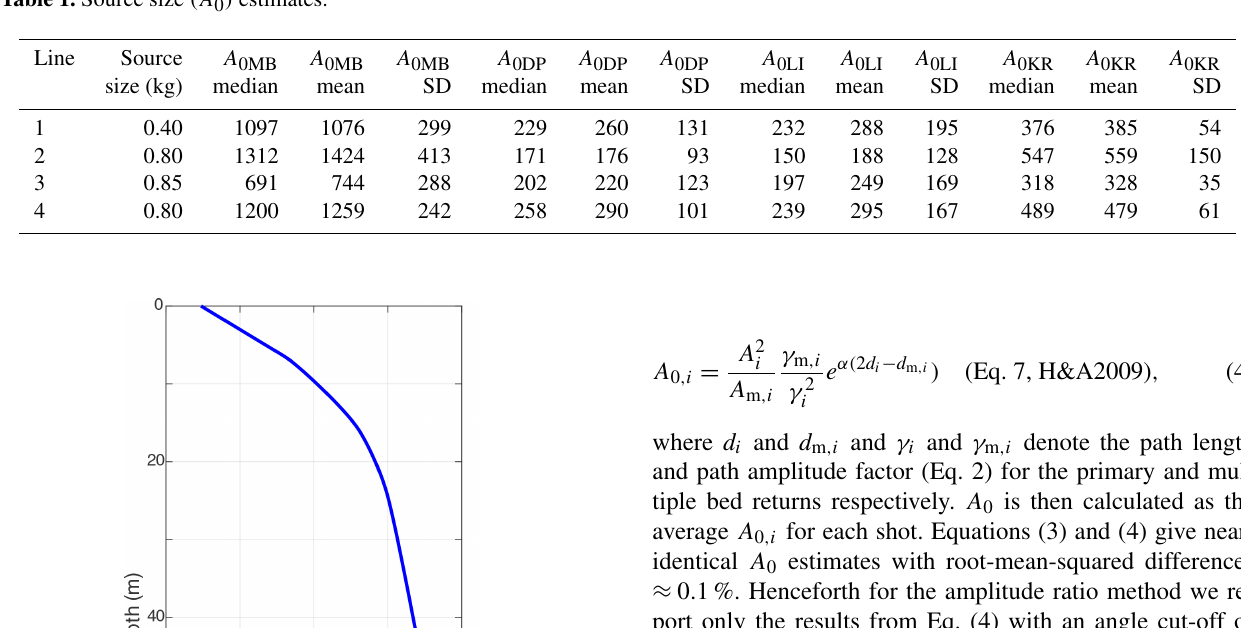
Table 1. Source size (A 0 ) estimates.